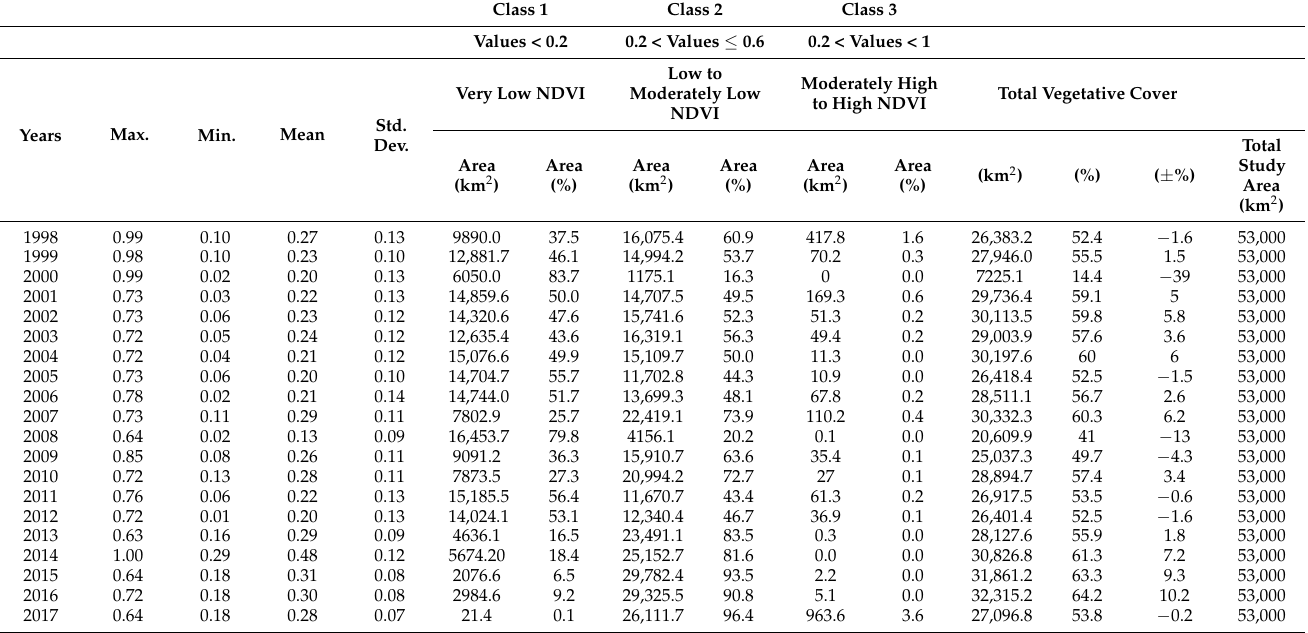
Table 3. The max, min, mean, and std. dev. of NDVI values and the area of vegetative cover and the NDVI-Based Vegetation Density Classes in KRI from 1997 to